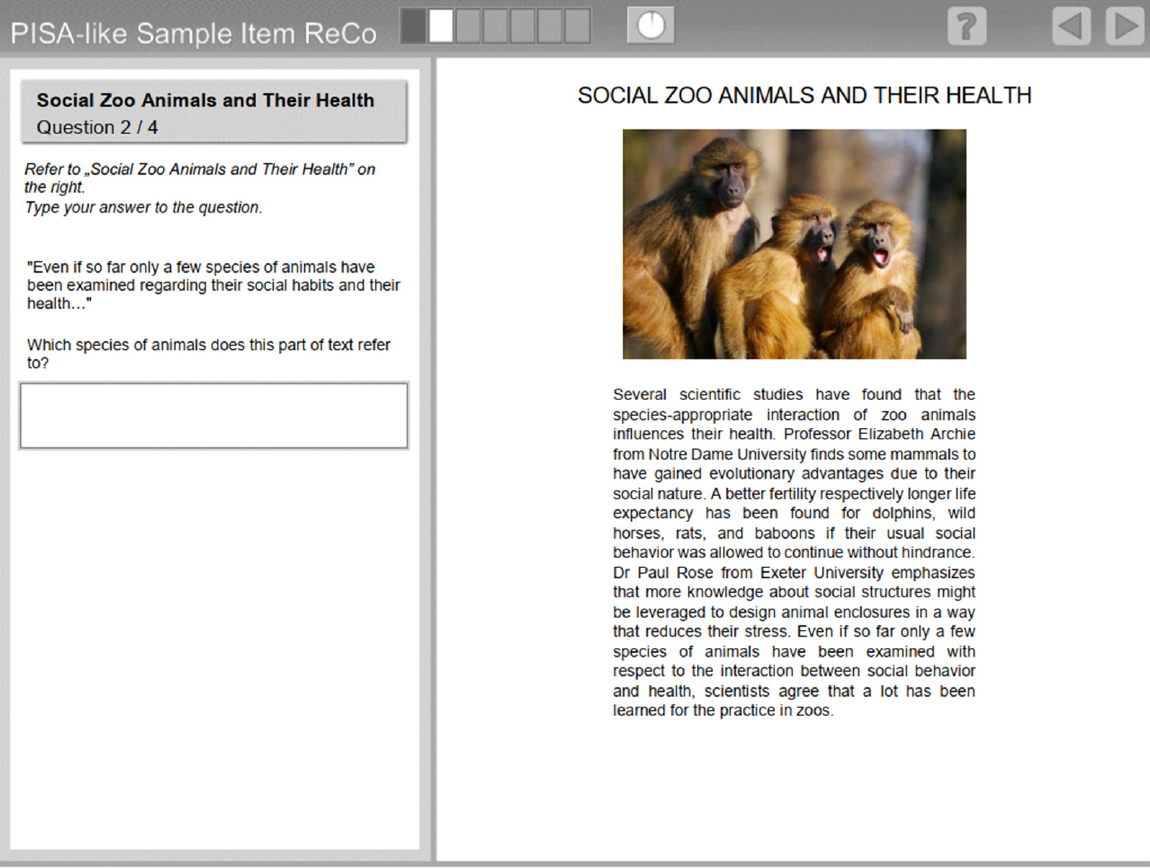
Figure 6. Demo item (more information in the app’s INFO tab).